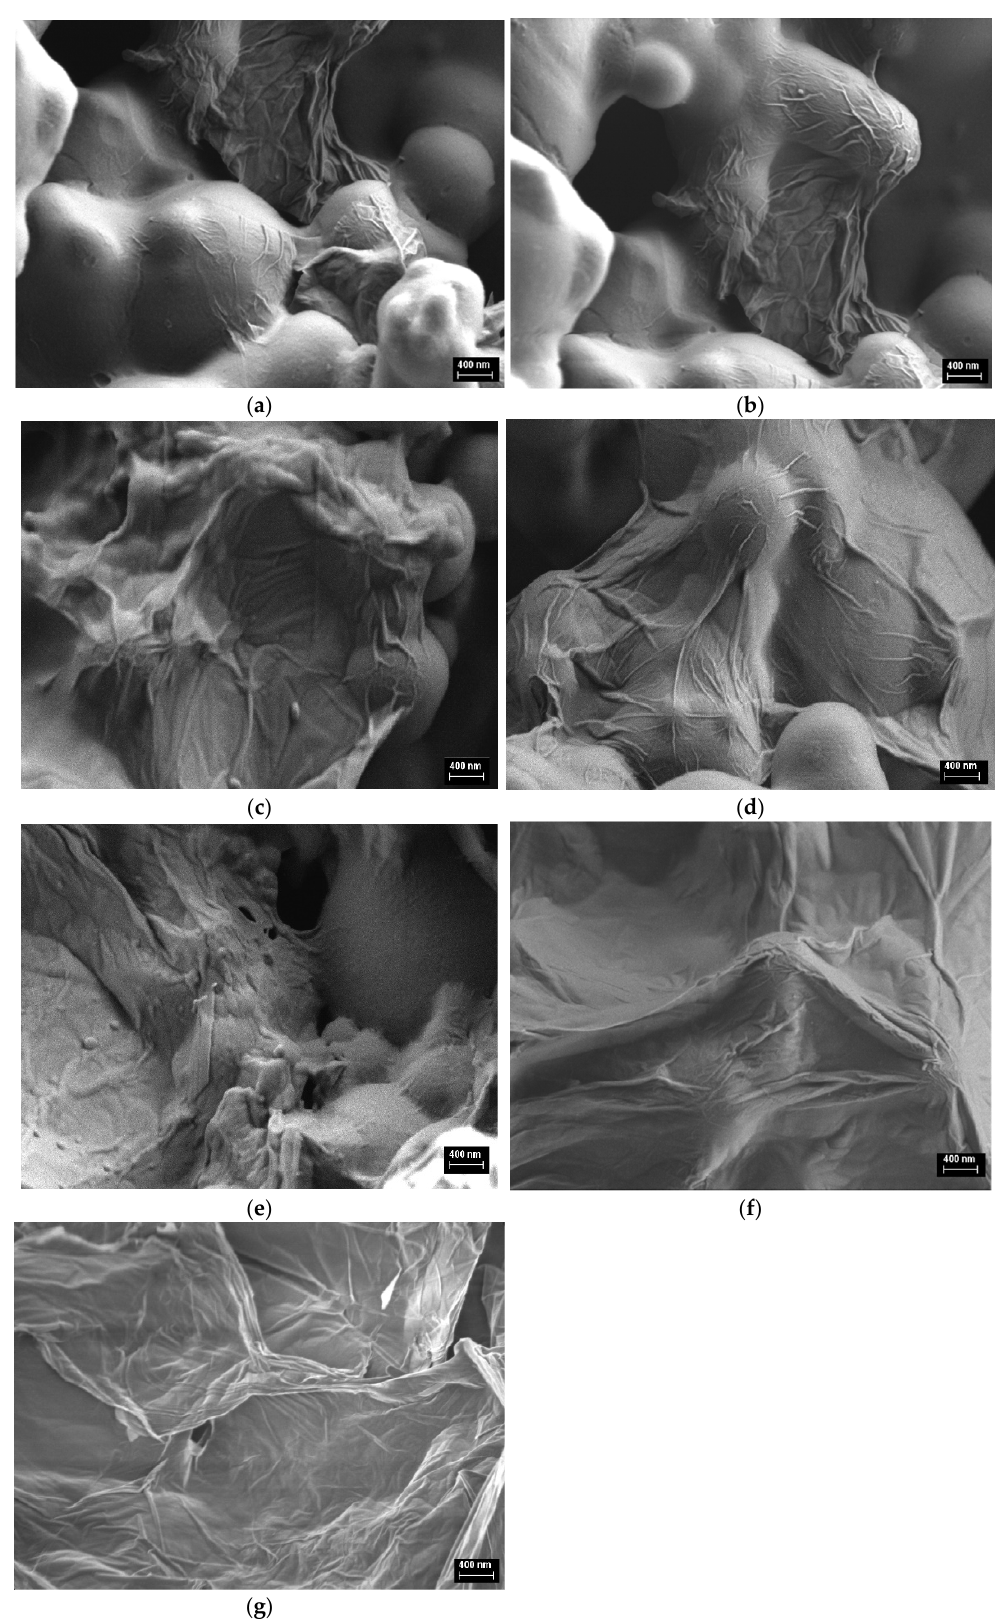
Figure 2. SEM micrographs of PVC/graphene oxide (GO) composites with a GO concentration equal to 0.5 wt.% ( a ), 1 wt.% ( b ), 2 wt.% ( c ), 3 wt.% ( d ), 4 wt.% ( e ), and 5 wt.% ( f ). GO sheets ( g ).